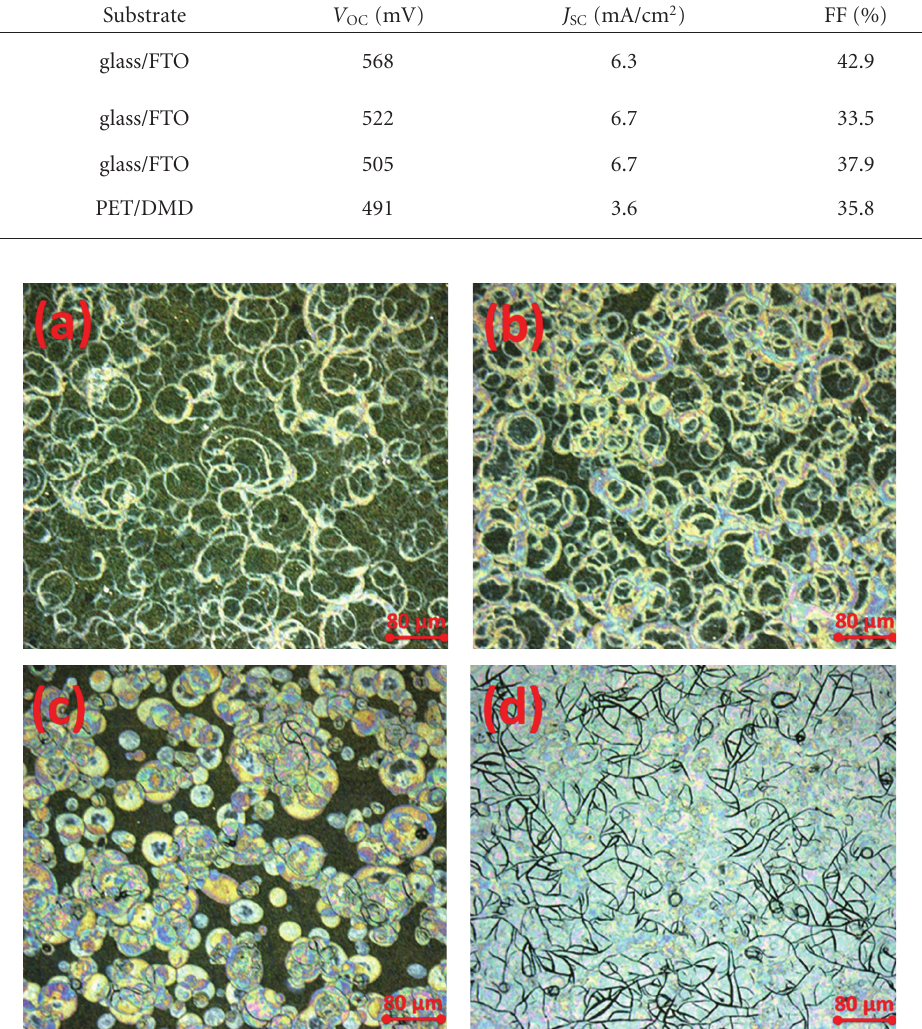
Figure 1: Optical images of TiO x realized on glass/FTO substrate with 4 sprays at di ff erent TTIP concentration in 2-isopropanol: (a) 1%, (b) 2%, and (c) 5%. In case of (d), that corresponds to a 5% concentration with 8 sprays, white powder formation is